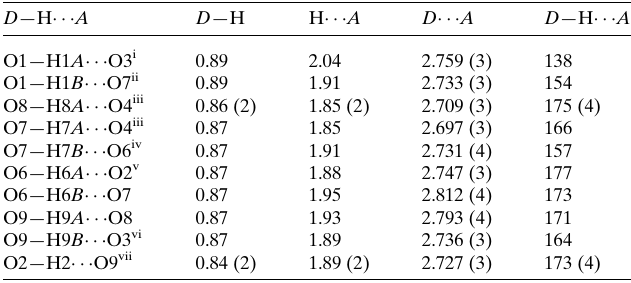
Table 1 Hydrogen-bond geometry (A˚ , (cid:4) ).